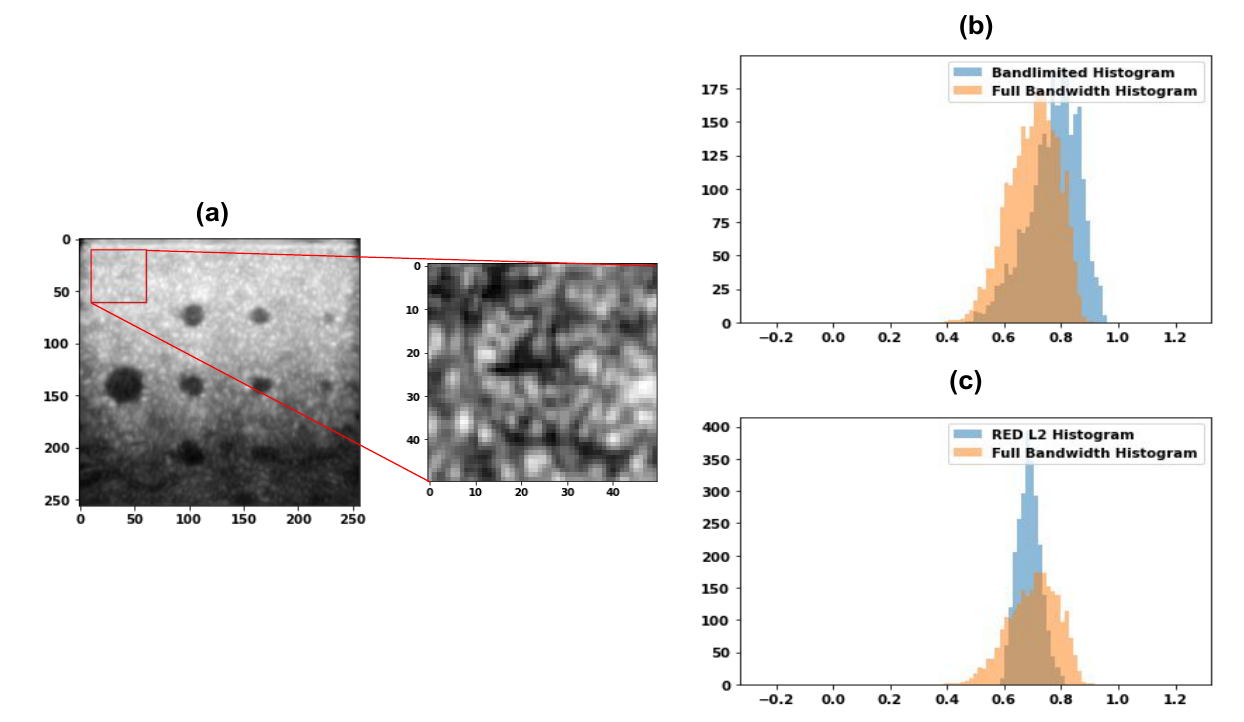
Figure 11. ( a ) Sample of a Commercial phantom image and the corresponding patch area which we want to analyze, ( b ) Comparison of the histogram of band-limited and full bandwidth data, and, ( c ) REDNet PL2 model and full bandwidth